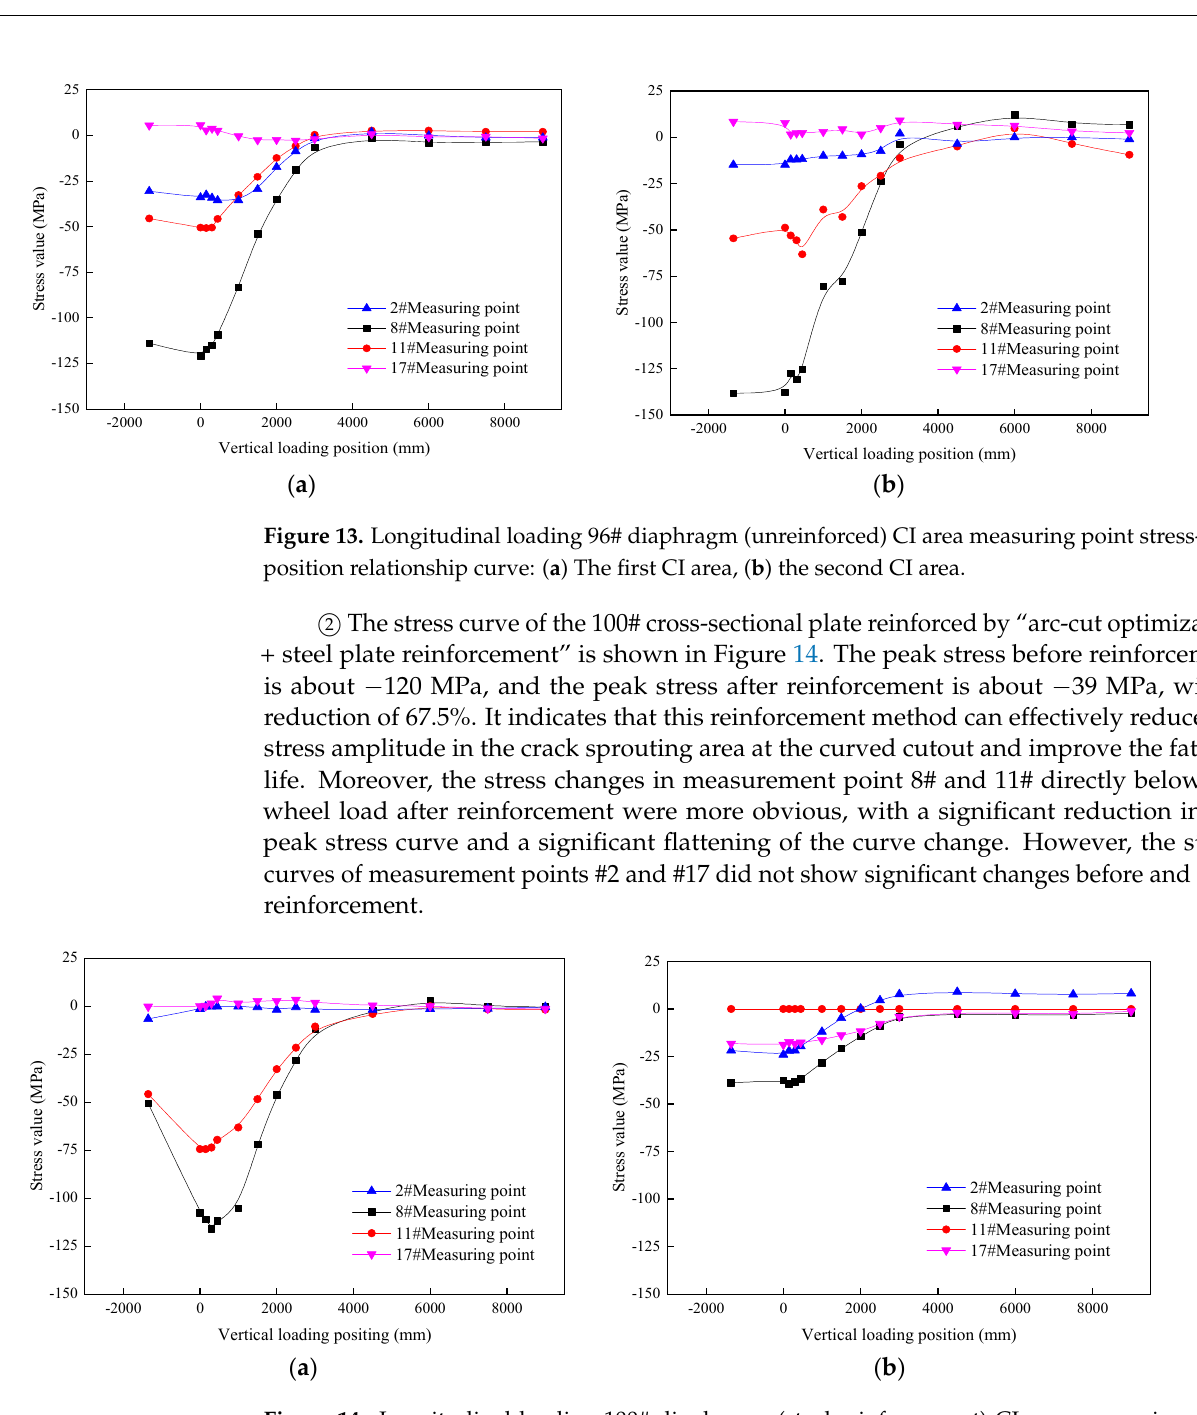
Figure 14. Longitudinal loading 100# diaphragm (steel reinforcement) CI area measuring point stress-load position relationship curve: ( a ) Before reinforcement, ( b ) after reinforcement. ③ The stress-load position curve of 105# cross-sectional plate optimized by using a curved cut is shown in Figure 15. The peak stress at the curved cutout of 105# diaphragm before the reinforcement was about -115MPa, and the peak stress after reinforcement was about − 59.3 MPa, and the drop only reached 48.4%. From Figure 15, it can be seen that the stress curve changes the same trend before and after reinforcement, but the stress curve changes more gently after reinforcement, which is more favorable to the force of the curved cut. The use of the arc-shaped cut optimization could reduce the stress amplitude to a certain extent, however, the reinforcement effect was slightly inferior to the effect of steel plate